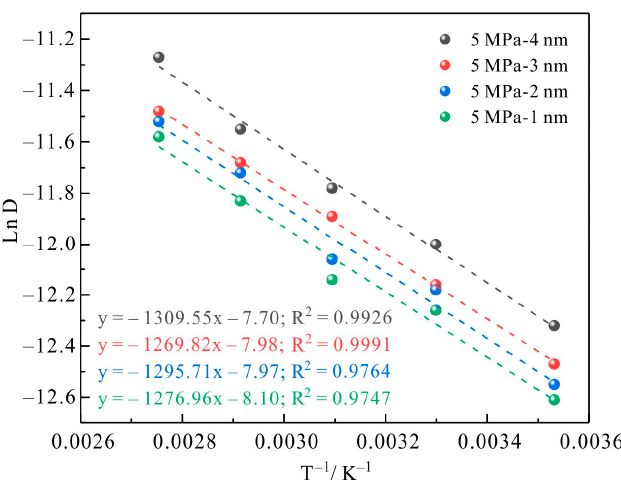
Figure 15. Activation energy with same pressure and different pores.